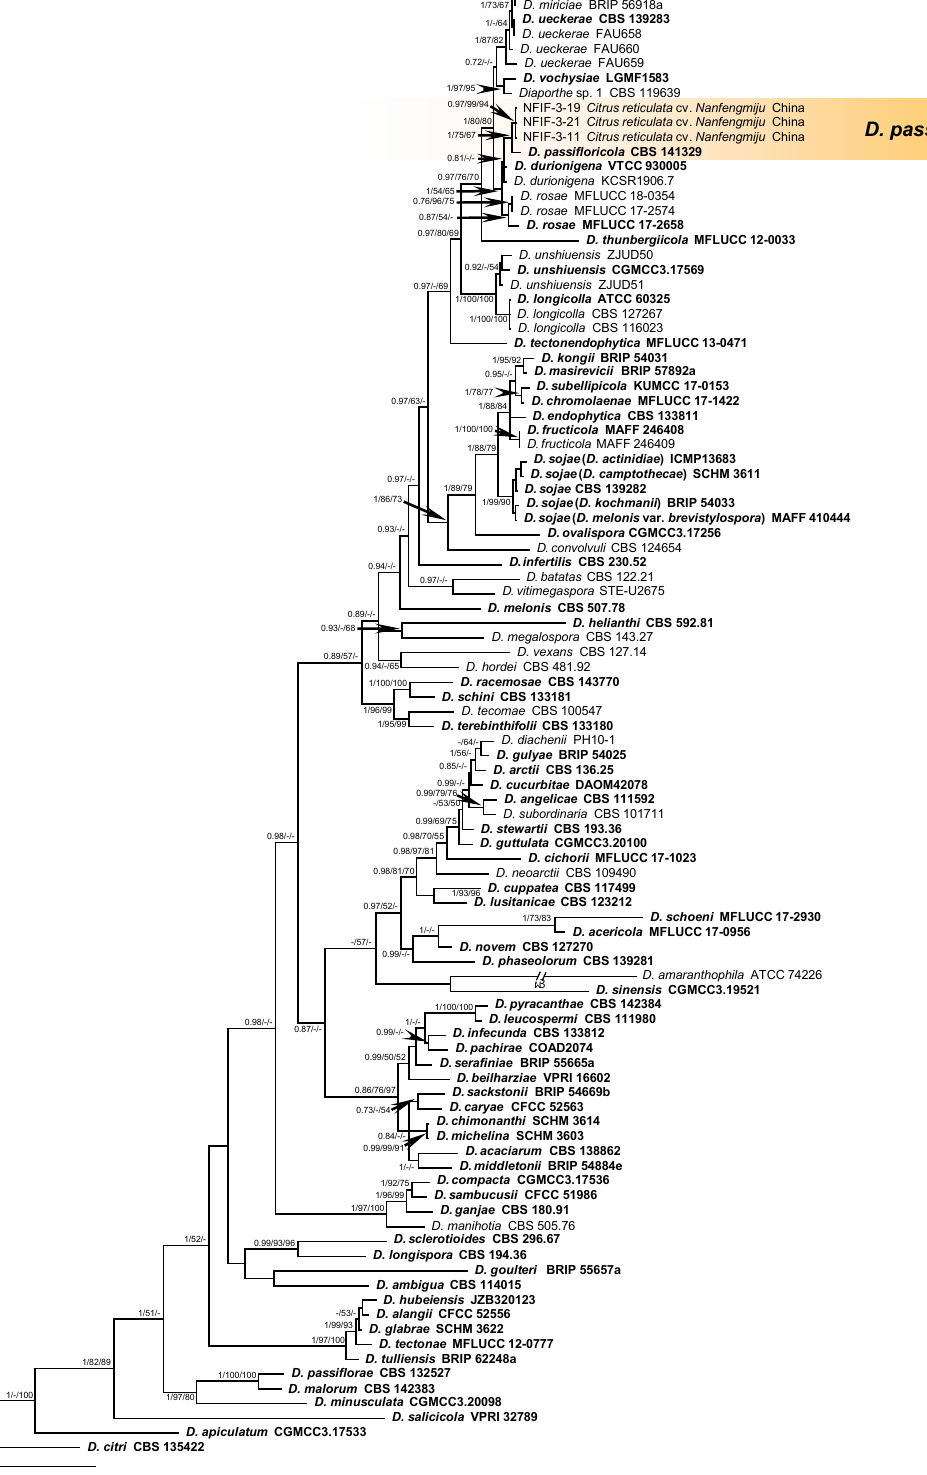
Figure 4. Bayesian inference phylogenetic tree is generated from the analysis of the combined sequences of five loci (ITS, TUB , TEF , HIS , and CAL ). Posterior probabilities support values ≥ 0.7 and Bootstrap support values ≥ 50%, Bayesian posterior probabilities values (BIPP)/ Maximum likelihood bootstrap values (MLBS)/ Maximum parsimony bootstrap values (MPBS) are displayed at the nodes. The tree is rooted with D. citri CBS 135422. Ex-type, ex-epitype, and holotype cultures are indicated in bold . The codes of isolates used for phylogenetic tree are given.